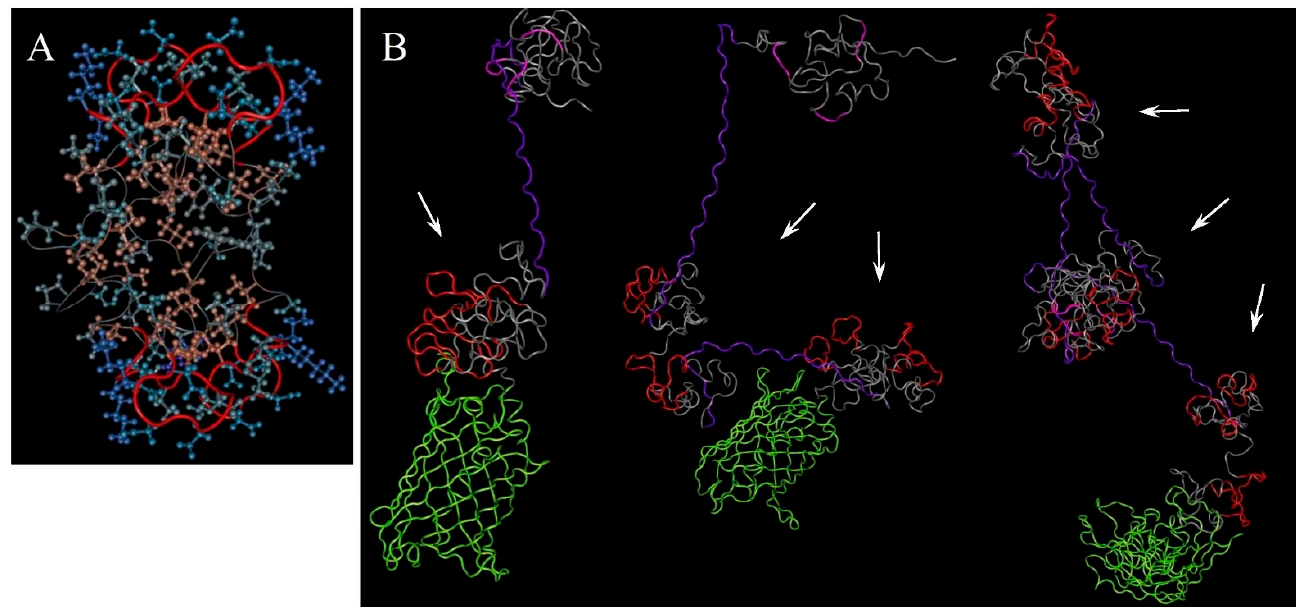
Figure 2. ( A ). A graphical presentation of the 4MBS-domain generated by Cn3D4.3. The protein sidechains and backbones are coloured based on the hydrophobicity scheme* of Cn3D4.3 with the exception of MBSs, the backbones of which are shown in red. ( B ). The putative tertiary structure of the designed proteins E2-13W4, E1-W8, and E1-W12 (from left to right) predicted by trRosetta with restraints from both deep learning and homologous templates. The graphical presentation was generated by Cn3D4.3. MBSs are shown in red, F3 peptide is shown in purple, RGD is shown in magenta, and EmGFP is shown in green. The arrows indicate the 4MBS-domains. * Protein backbones and sidechains are coloured according to their free energy of immersion in water. Blue is hydrophilic and red is hydrophobic